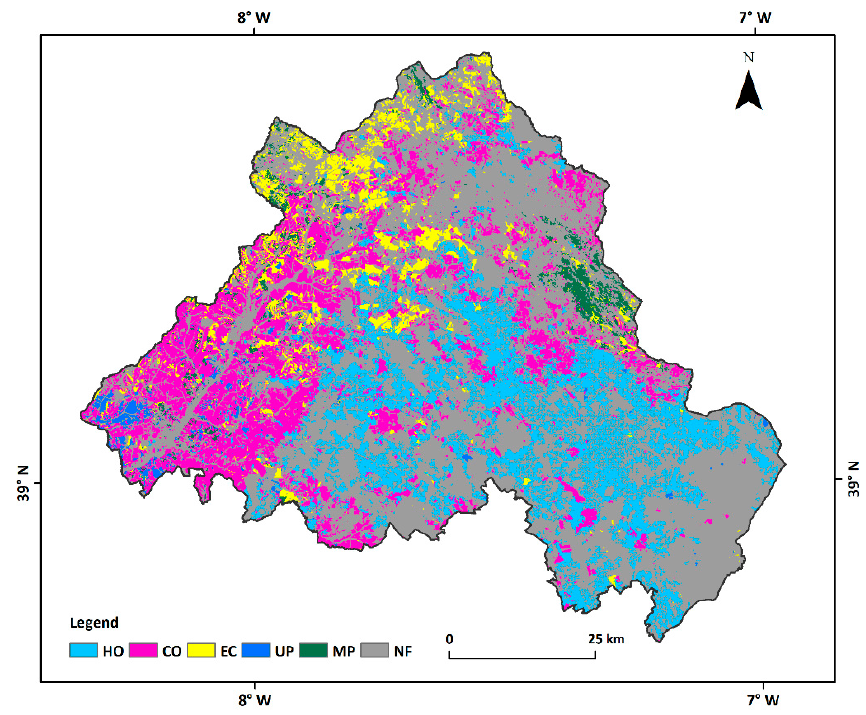
Figure 3. Land use/cover map for Alto Alentejo region. Table 5. Confusion matrix.